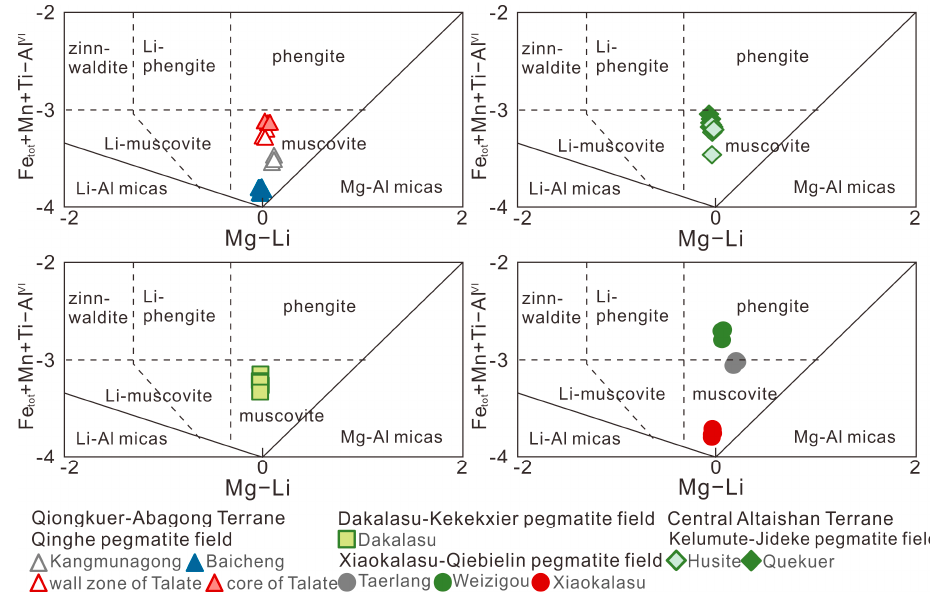
Figure 3. Mg-Li vs. Fe tot + Mn + Ti-Al VI diagram according to